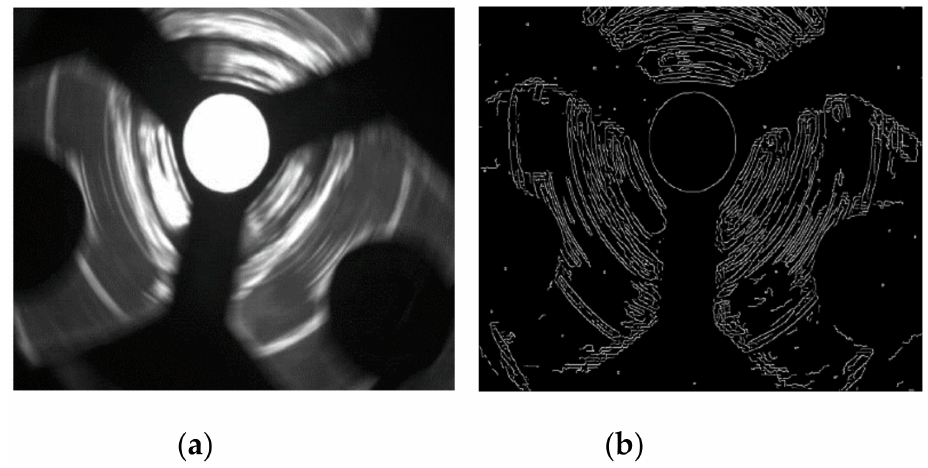
Figure 34. Application of the canny edge detection for identifying edge pixels: a grey-scale image of the master cylinder ( a ) Canny edge detected pixels ( b ) [32].